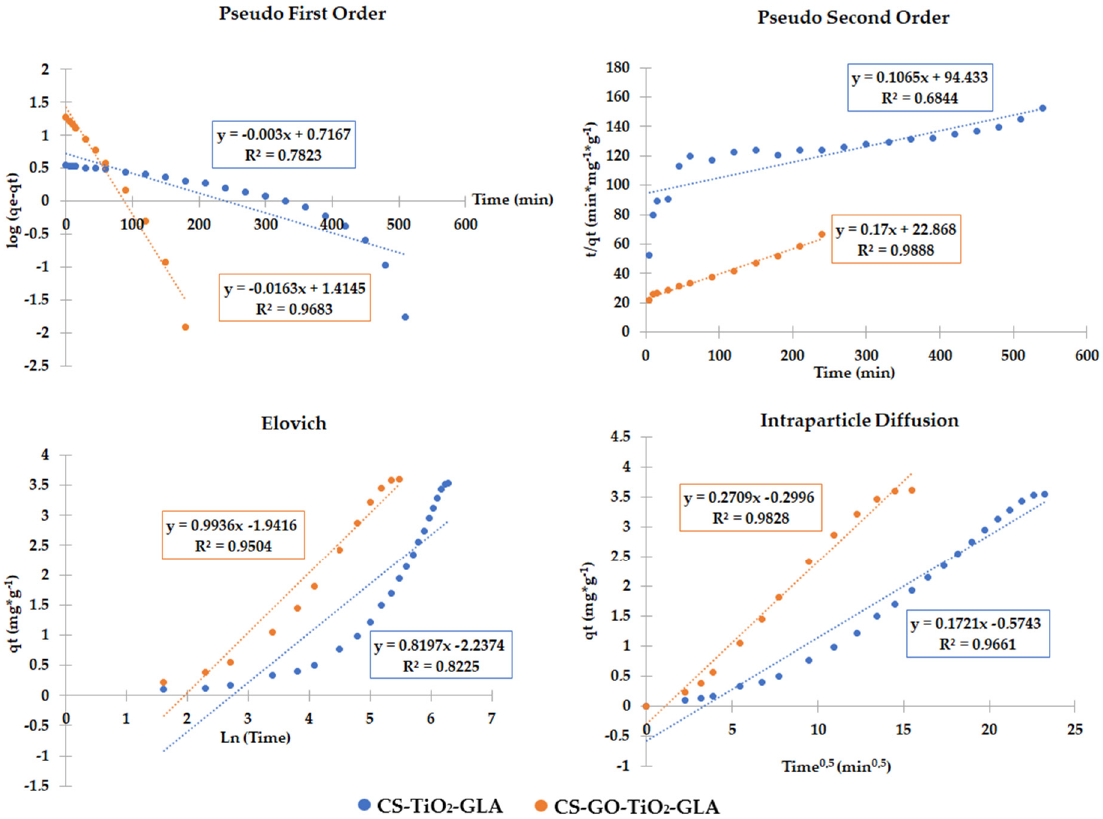
Figure 3. Adsorption kinetics fitted to the different models for FD&C Red 40 dye. (Initial dye concentration = 45 mg L − 1 ; pH = 3.0; adsorbent dosage = 0.3 g; solution volume = 25 mL; stirring speed = 400 rpm; temperature 25 °C). Table 8. Calculated parameters of the different kinetic models for the adsorption of FD&C Red 40 dye on the two adsorbent systems.